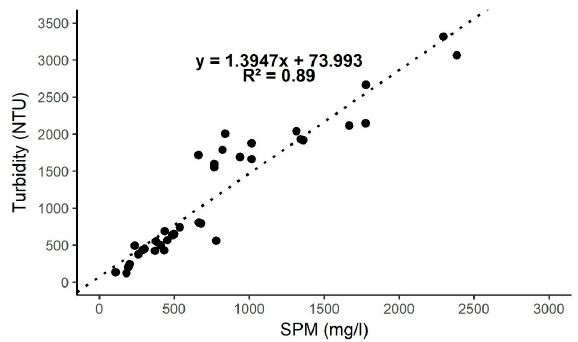
Figure 2. Turbidity as a function of SPM from in-situ coincident measurements over the Agoufou Lake (N = 38). R 2 indicates the Pearson’s correlation. Table 3. R 2 for NIR bands and for the sum of the NIR and red bands as a function of SPM. R 2 indicates the Pearson’s correlation.